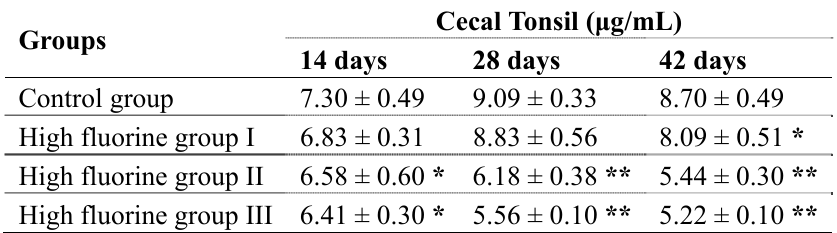
Table 3. Change of the IgG content in